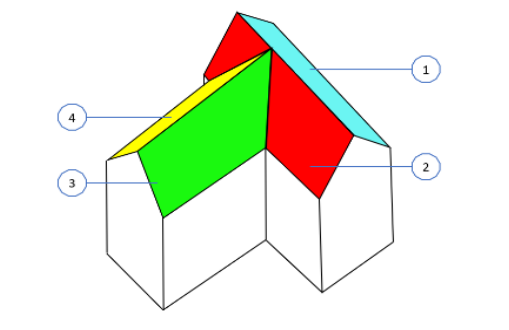
Figure 4 . The four different facades